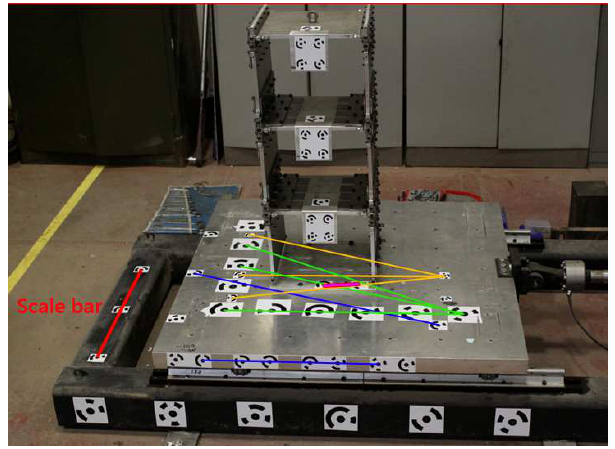
Figure 5: Selected measurements for validation comparison.